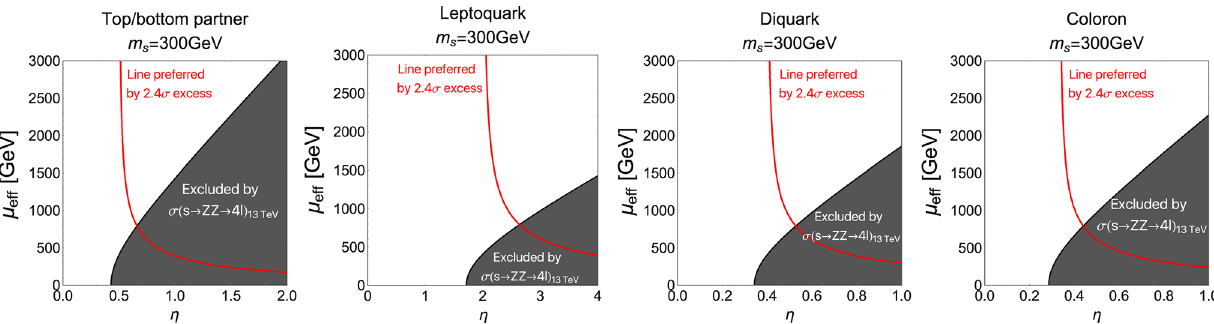
to be K = 1 . 6. The region 10 − 4 (cid:3) θ 2 (cid:6) 1 is assumed. Note that the plotted region of η in horizontal axis differs panel by